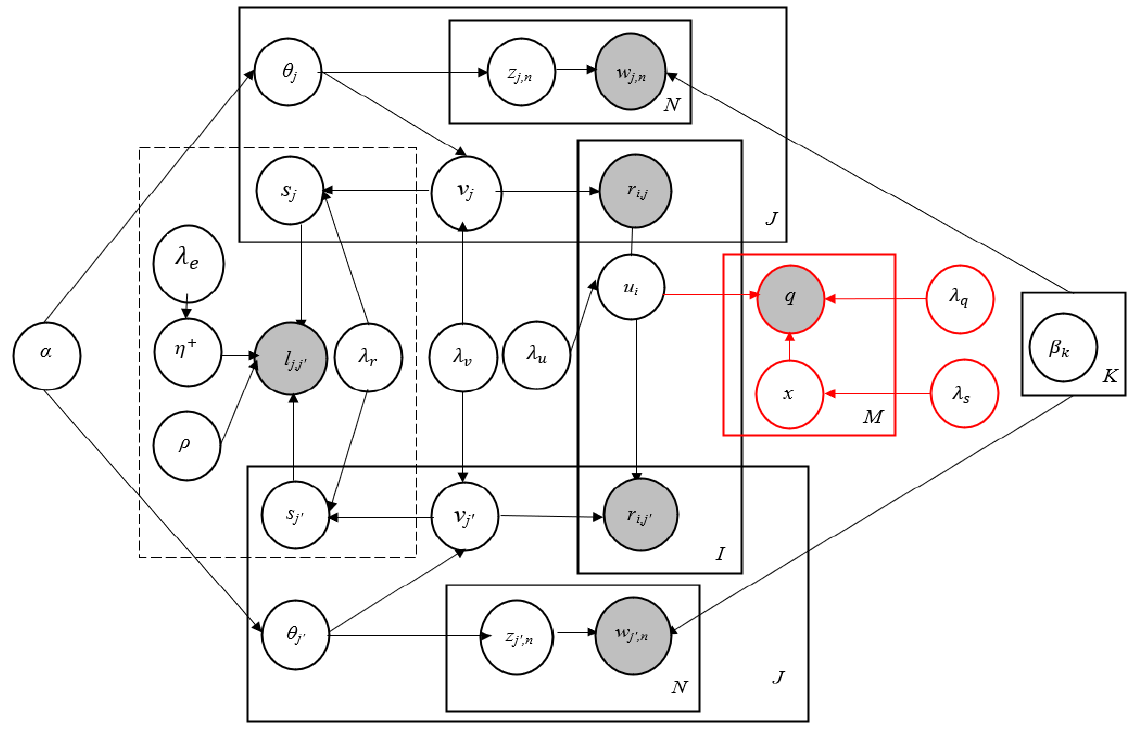
Figure 2. RCTR–SMF Model.